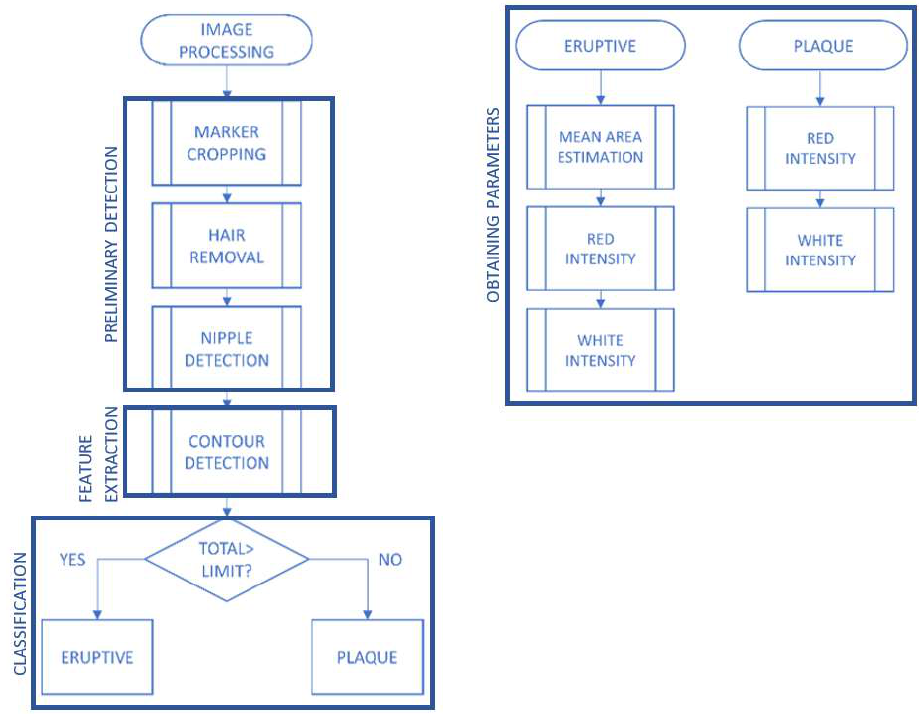
Figure 1. General operation diagram.